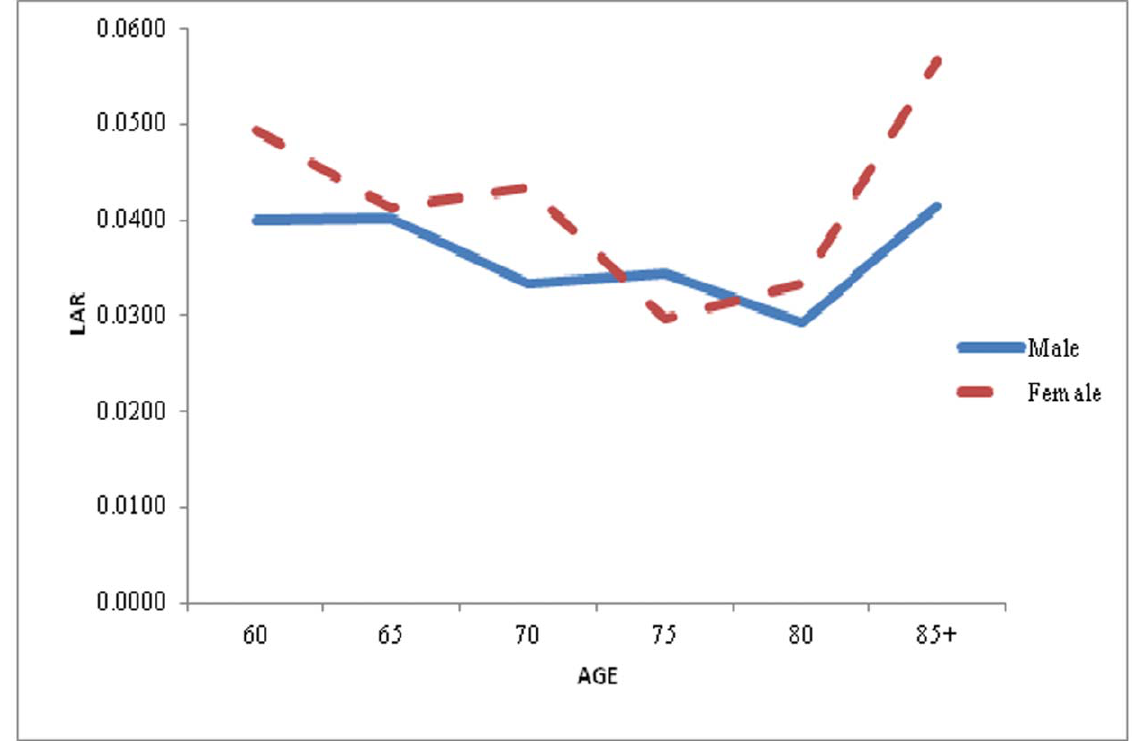
Figure 4. Life Table Aging Rate (LAR) for Male and Female in the older age, India, 2006.